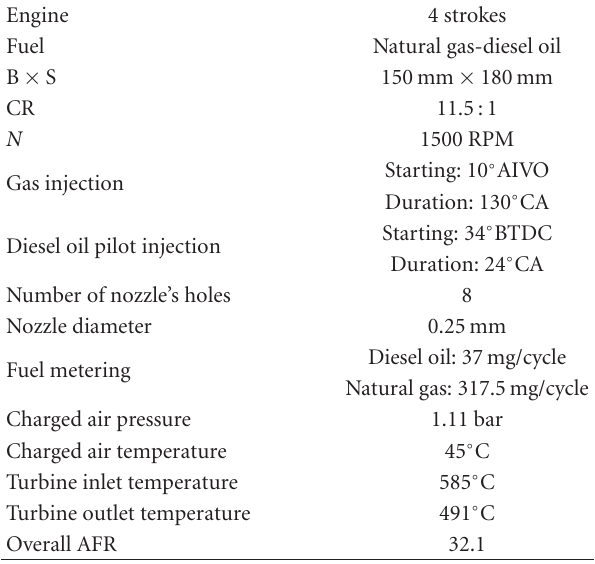
Table 1: Engine specification and operation conditions.